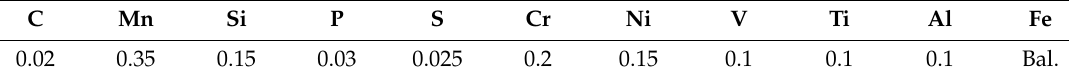
Table 2. Diamond tool wear mitigation techniques to machine ferrous metals.